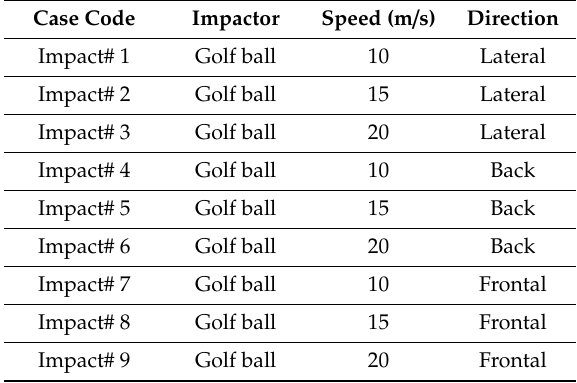
Figure 2. Setup of frontal and lateral impact by golf ball in the FE head model. Table 4. The summary of impact cases by golf ball applied in FE modeling for estimating the ranges of strain